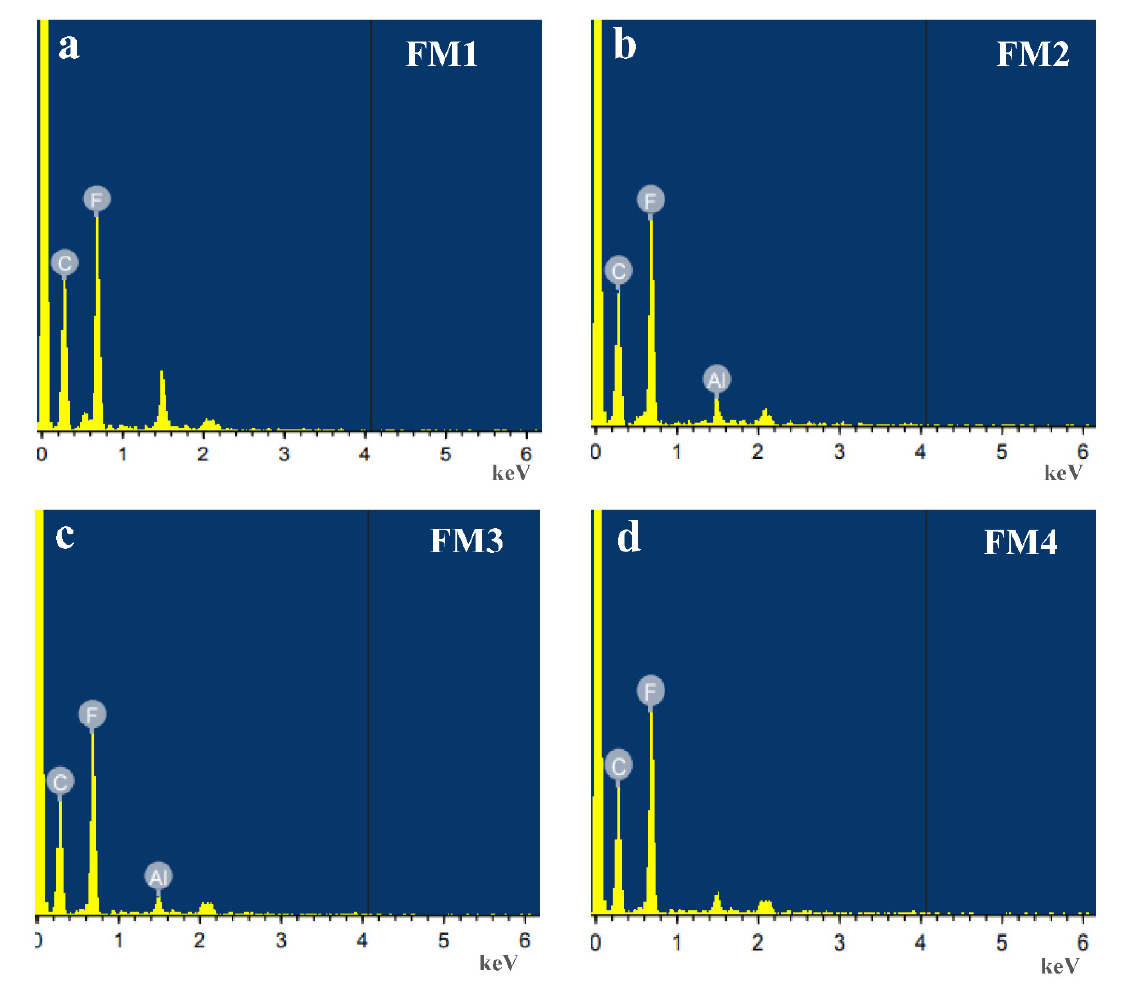
Figure 9. EDX analysis for the selected PVDF-PAC fabricated membranes with different compositions: ( a – d ) for (FM1–FM4).